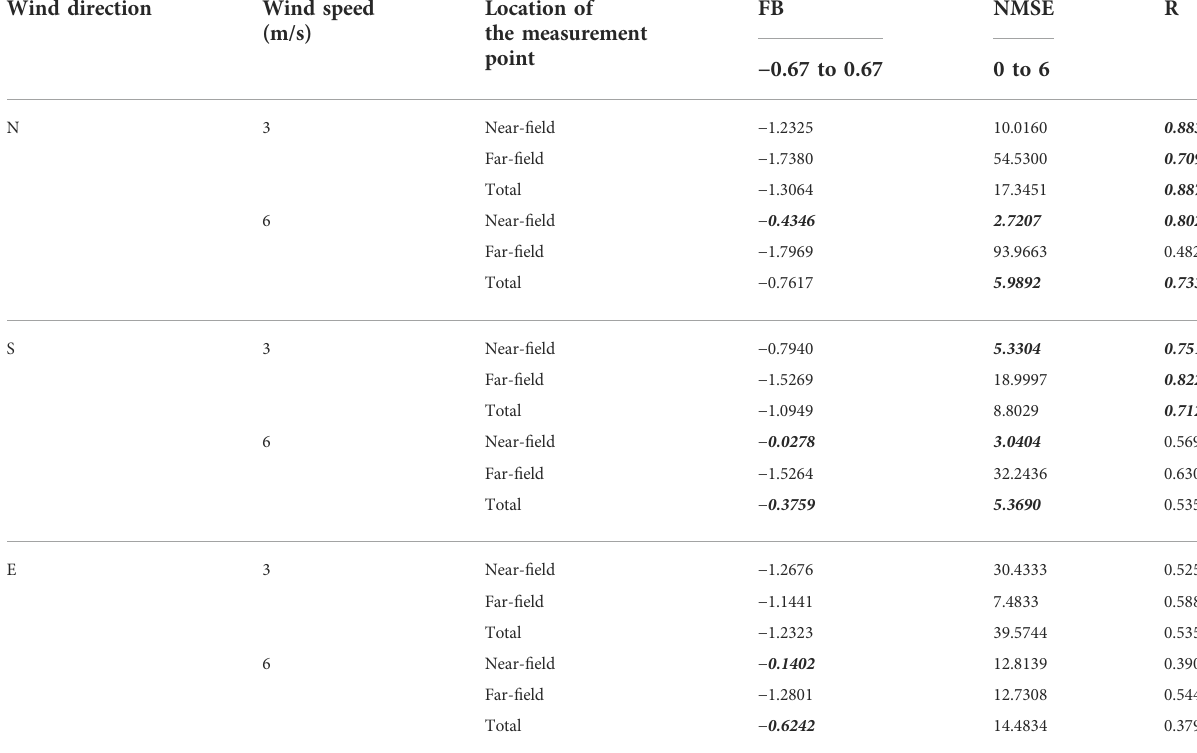
TABLE 2 Evaluation indexes for the comparison of the wind tunnel experiment and CALPUFF simulation under different wind directions and speeds. Wind